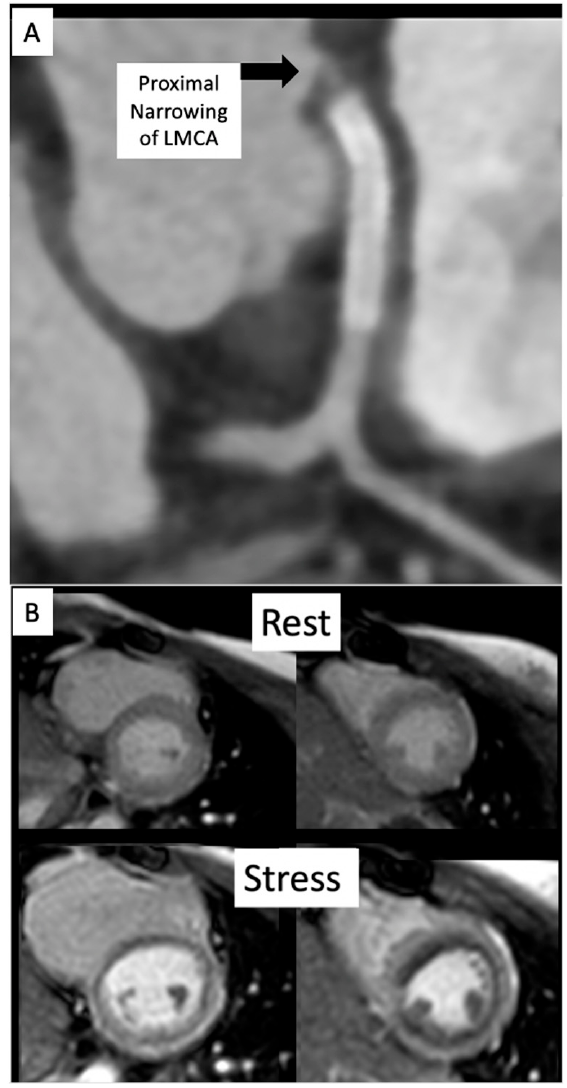
Figure 21. ( A ) CT on follow-up for patient from Figure 20 demonstrates a segment of near complete occlusion at the most proximal aspect of the left main coronary artery (LMCA), immediately prior to the previously placed stent. ( B ) Cardiac MRI demonstrated inducible perfusion defects along the anteroseptal, anterior, anterolateral, and lateral walls, at the basal and mid-ventricular level, as well as in the anterolateral papillary muscle (territory of the LMCA). No areas of late gadolinium enhancement to indicate myocardial fibrosis/injury are present. Patient proceeded to the catheterization lab for additional stenting of the LMCA ostium.